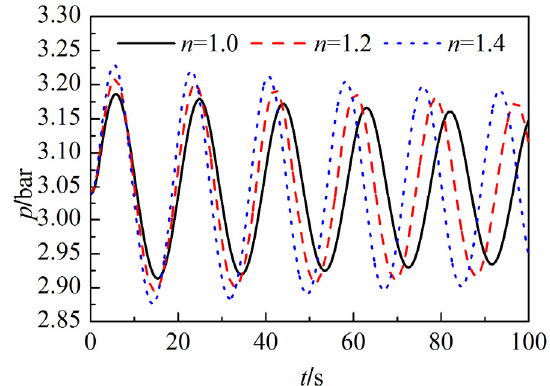
Figure 21. Oscillation of pressure.